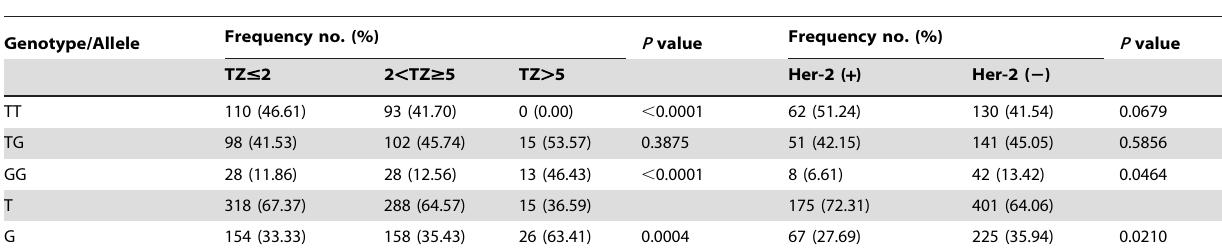
Table 3. Clinical features associated with rs1884444 in IL23R gene.